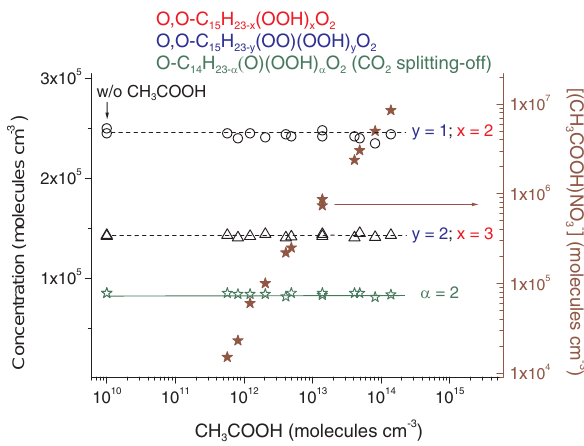
Figure 9. Highly oxidized RO 2 radicals from the ozonolysis of β -caryophyllene from the three product groups, simple AutOx. with O,O–C 15 H 23 − x (OOH) x O 2 , x = 2 and 3, ext. AutOx. with O,O–C 15 H 23 − y (OO)(OOH) y O 2 , y = 1 and 2, and ext. AutOx. - CO 2 with O–C 14 H 23 − α (O)(OOH) α O 2 , α = 2 as a function of the CH 3 COOH concentration. CH 3 COOH acts as a sCI scavenger. The black-coloured data points stand for the RO 2 radicals from the simple AutOx. group and from the ext. AutOx. group with x = 2 and y = 1 (circle) as well as with x = 3 and y = 2 (trian- gle). The adduct (CH 3 COOH)NO − was detected with lower-limit 3 concentrations which are a factor of 2 × 10 7 lower than the acetic acid concentration in the tube. [ β -caryophyllene] = 8 . 3 × 10 10 , [O 3 ] = 4 . 7 × 10 10 , [CH 3 COOH] = (0–1.4) × 10 14 moleculescm − 3 ; reaction time is